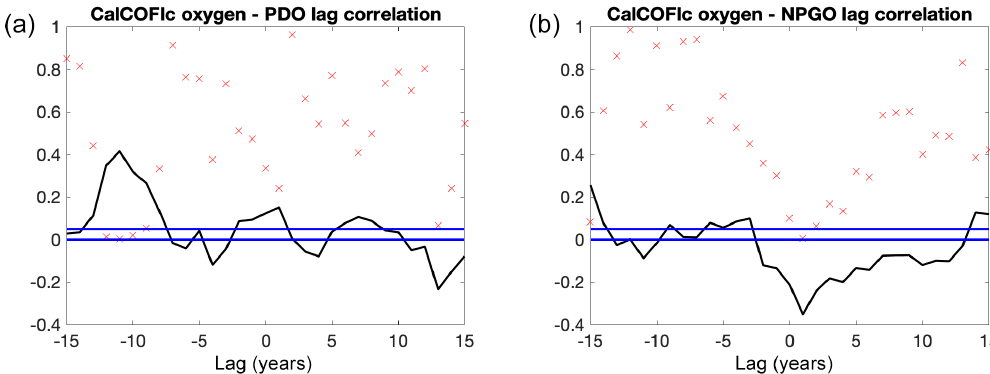
Figure 6. Correlation between oxygen at 50–300m in the region 34–35 ◦ N, 121–122 ◦ W (CalCOFIc) and (a) the PDO and (b) the NPGO (black lines) shifted between − 15 and + 15 years for the years after 1976 and the p values (x) which often are used to declare non-significant correlation for p ∼ >0.05 (blue lines for 0 and 0.05). For positive years PDO–NPGO lags; for negative years they